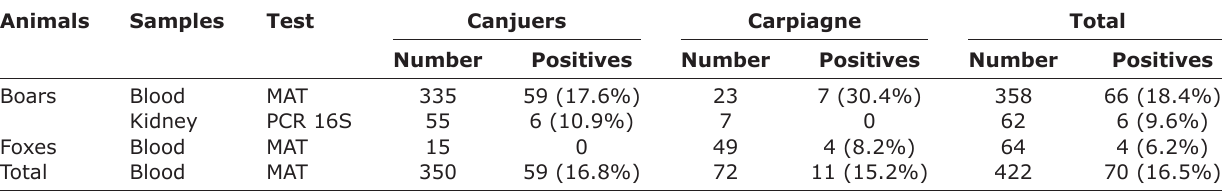
Table-1: Percentage of positive samples for leptospirosis according to species. Animals